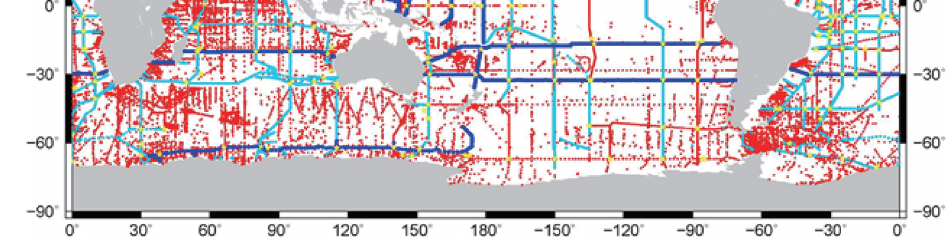
Figure 3. Same as Fig. 1 but for silicate.